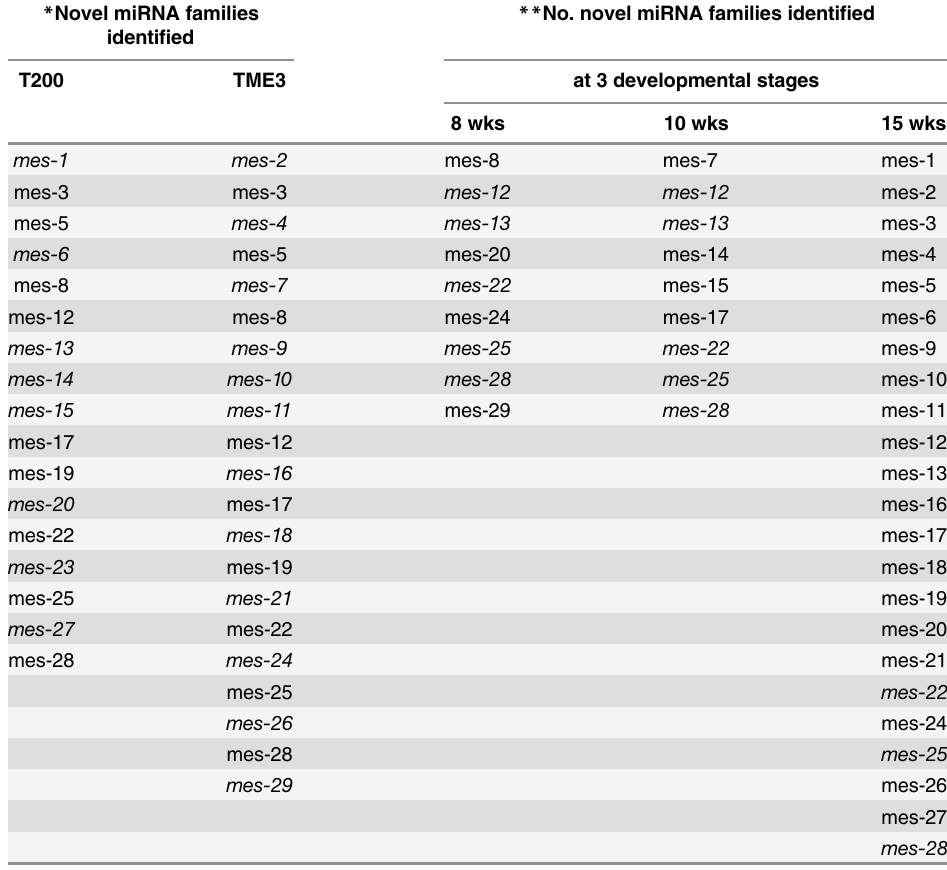
Table 2. Novel miRNA families identified in cassava T200 and TME3 and at 3 stages of development post acclimatization from tissue culture explants. * Novel miRNA families identi fi ed